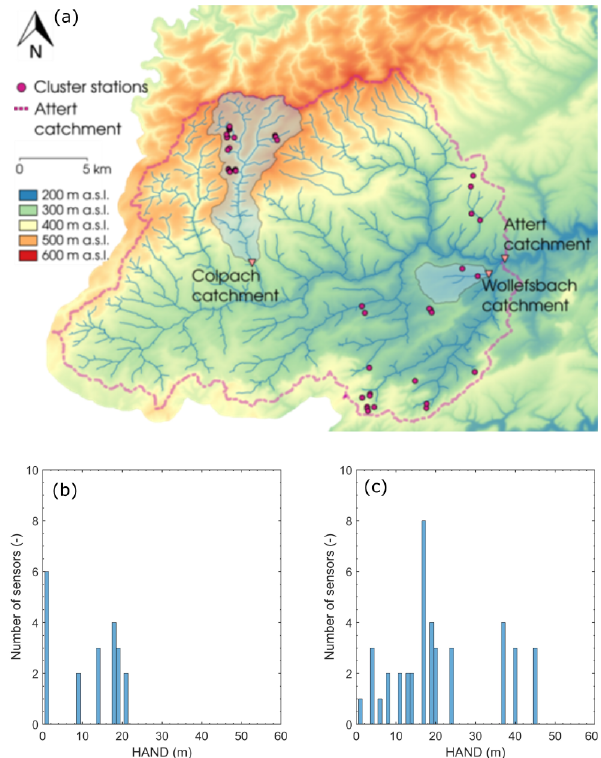
Figure 3. Map of the Attert basin with the Colpach and Wollefs- bach catchments ( a , taken from Loritz et al., 2017). The red dots mark the sensor cluster sites of the CAOS research unit, which col- lect, besides the standard hydro-meteorological data, soil moisture and the soil water potential. (b) and (c) show the distribution of the sensors with respect to HAND for the Wollefsbach and Colpach,